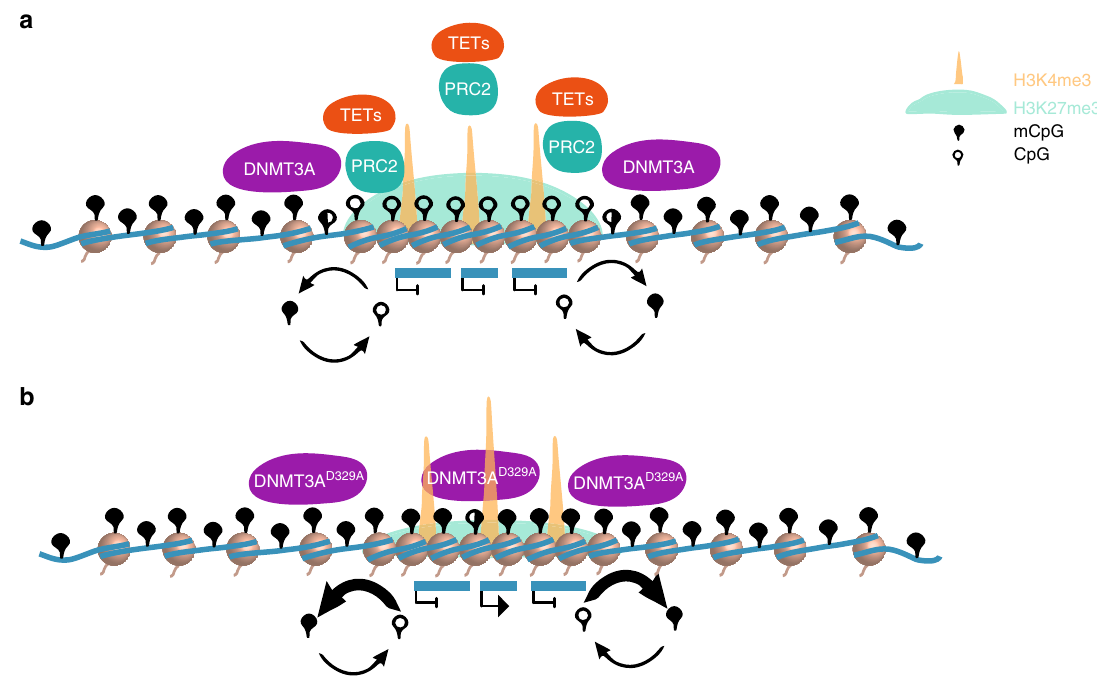
Fig. 9 Model of molecular mechanisms acting at bivalent domains. a Representation of current understanding of bivalent domain regulation. The PRC2 complex deposits H3K27me3 and compacts chromatin across the promoters and surrounding regions of transcriptionally silent, developmental genes 62 . TET proteins are recruited, which result in active removal of DNA methylation and protection of bivalent chromatin from de novo DNMTs 71 . DNMT3A is recruited to bivalent chromatin shores through an unknown mechanism, enabling active establishment of DNA methylation at the boundaries 60,70,71 . Through the competing actions of TETs and DNMT3A there is a cycle of DNA methylation turnover at the boundaries of bivalent domains. b Representation of bivalent chromatin dynamics in the presence of DNMT3A D329A . The mutant protein is able to access bivalent chromatin and establish methylation across the whole domain. The presence of DNA methylation appears to in fl uence the local chromatin environment and results in reduction of H3K27me3, potentially due to exclusion of PRC2 from methylated DNA. As a consequence, some genes become de-repressed and show an increase in promoter H3K4me3, while others maintain their transcriptional silencing, this is likely dependent on the availability and strength of necessary transcription